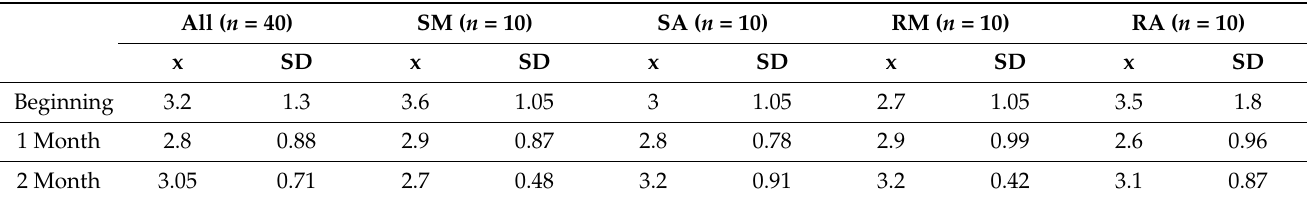
Table 6. Distance from abutment shoulder to